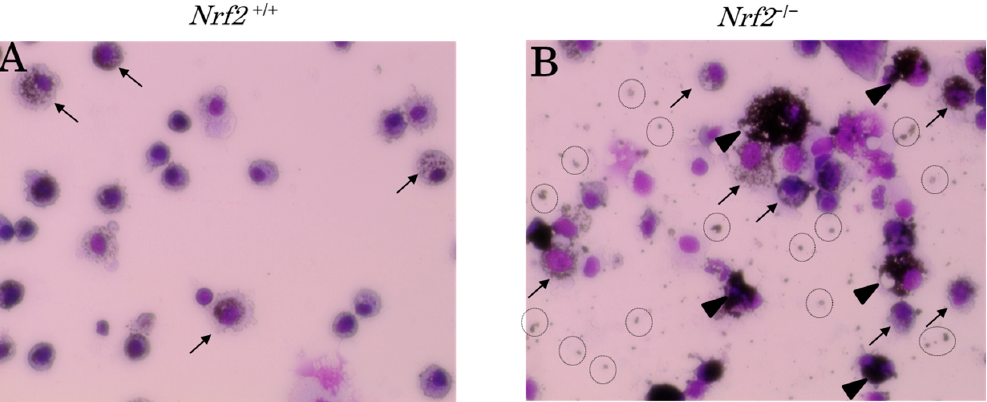
Figure 2. Representave optical micrographs of May-Gimza (Kobe, Japan) stained cell preparation (Original × 400). The pathologic features of diesel exhaust (DE) particles (DEP)-laden alveolar macrophages in the BALF on day 10 after BLM injection and after exposure to DE for 38 days. ( A ) DE plus BLM-treated group in Nrf2 +/+ mice; ( B ) DE plus BLM-treated group in Nrf2 − / − mice. Arrows indicate DEP-laden alveolar macrophages. Arrowhead indicates coal-black alveolar macrophages. Dotted ring indicates DEP in the extracellular background of the cytopreparation.